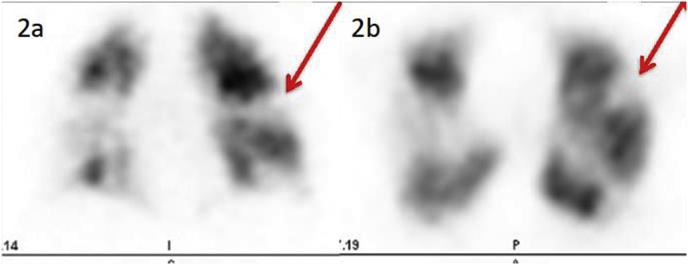
Coronal (2a) and axial (2b) SPECT lung perfusion scintigraphy images showing the same segmental perfusion defect. Note the sharper delineation of the perfusion defect on CT.